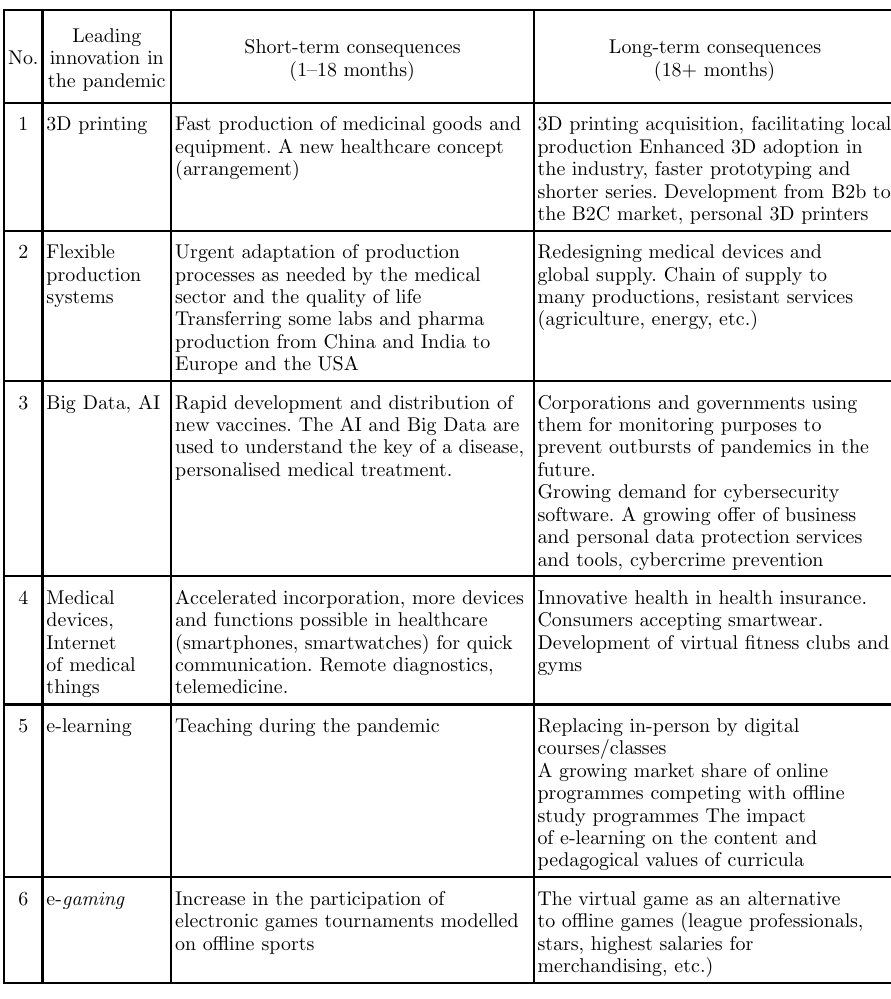
Short- and long-term consequences of the leading innovation of COVID-19 crisis Leading Short-term consequences Long-term consequences No. innovation